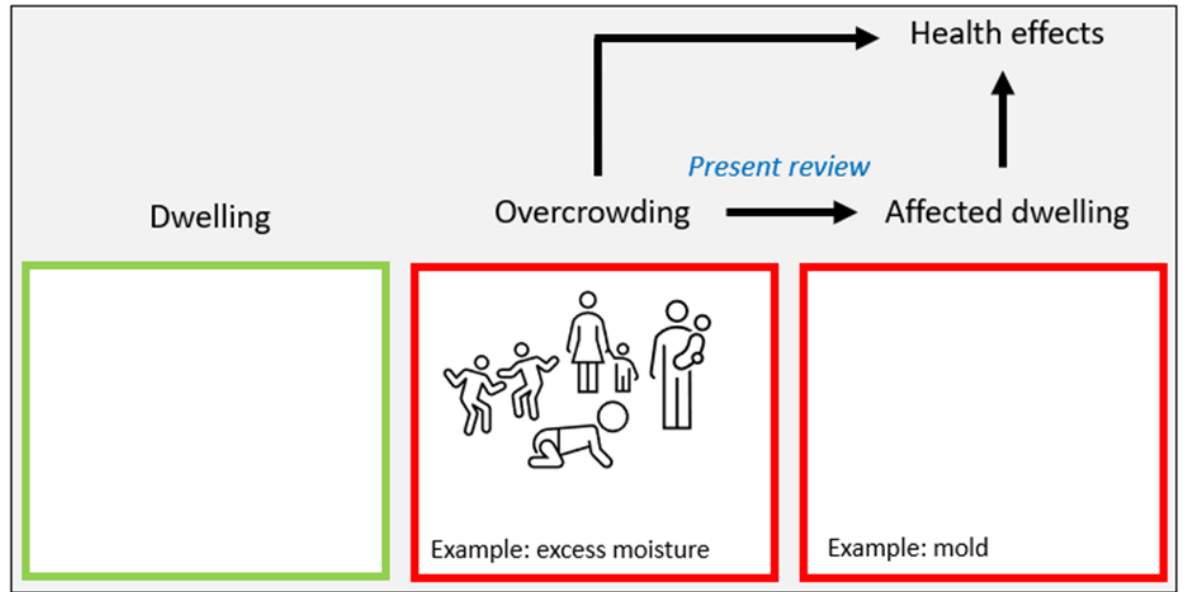
Figure 1. Outline of our underlying hypothesis in the present review. Overcrowding may affect dwellings, leading to dwelling condition characteristics of relevance for health, as exemplified by excess humidity (dampness/moisture) leading to mold. Thus, we did not review associations between overcrowding and health.